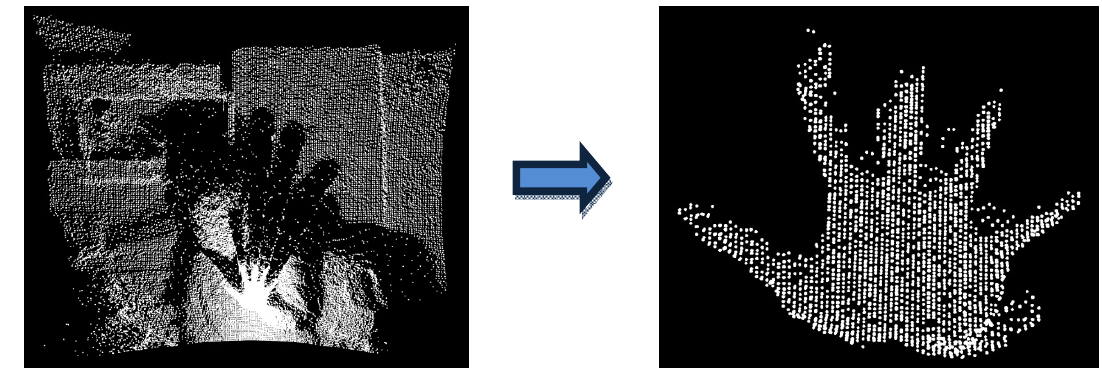
Figure 3. Objective of segmentation.